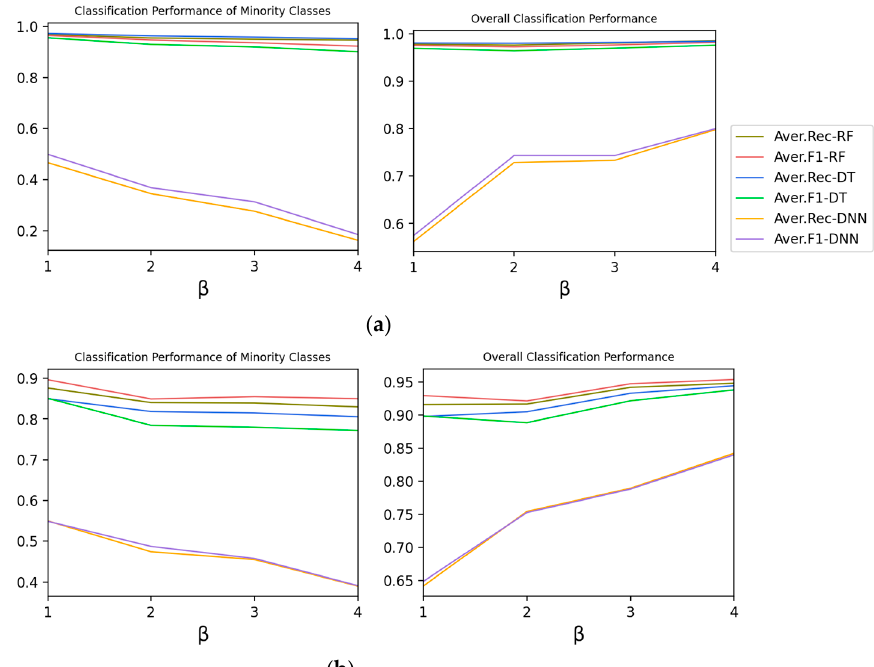
Figure 3. The effect of β on the classification performance of Type 1. ( a ) Moore Dataset; ( b ) CICIDS 2017 Dataset